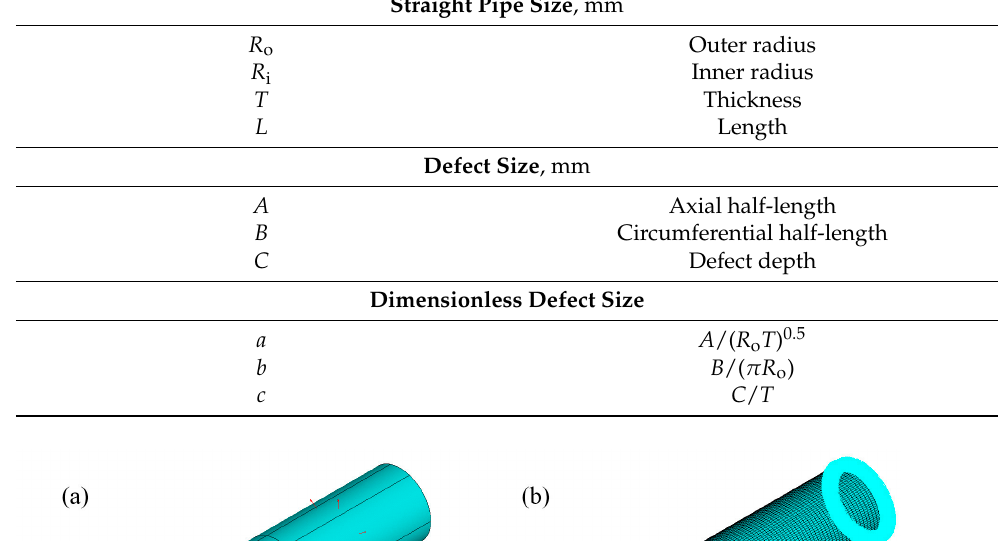
Table 2. The material parameters of the straight pipe.